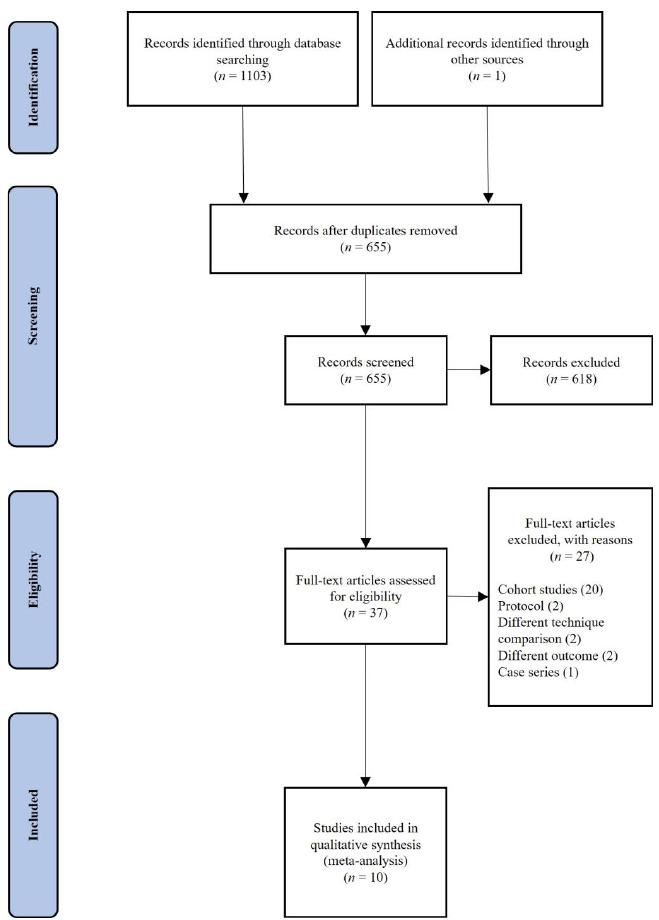
Figure 1. PRISMA (Preferred Reporting Items for Systematic Reviews and Meta-Analyses) flowchart of literature retrieval and selection.